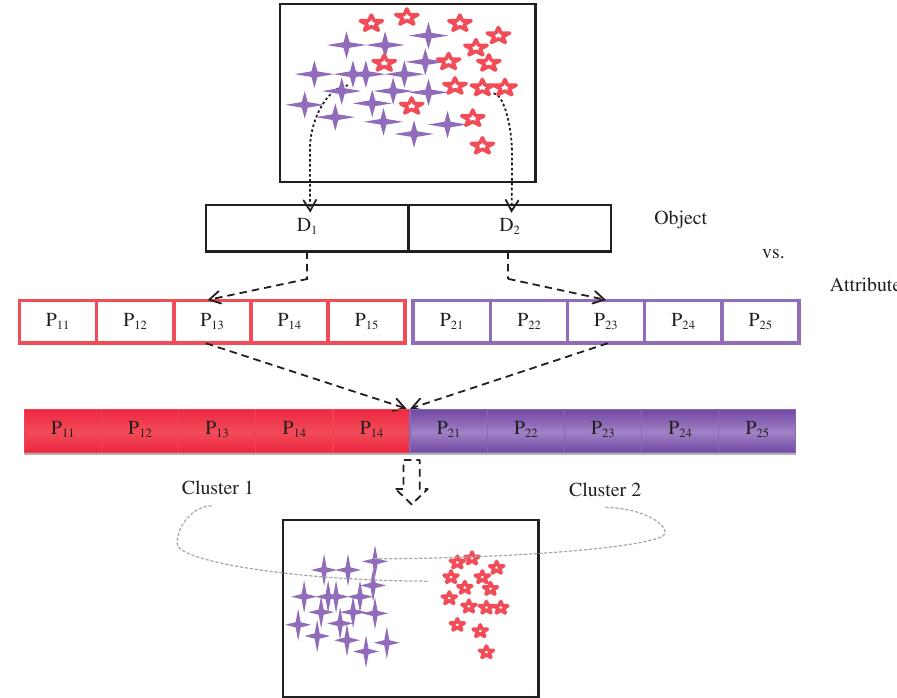
Figure 2: Solution